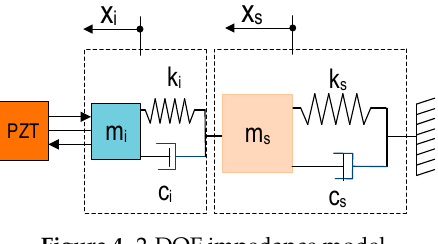
Figure 4. 2-DOF impedance model.